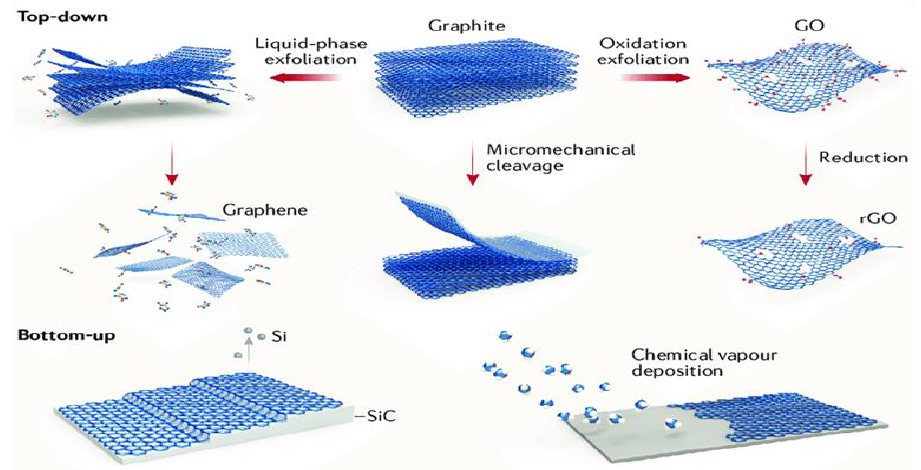
Figure 3. Several methods used for fabricating graphene. Reproduced from [49] with permission of Springer Nature.